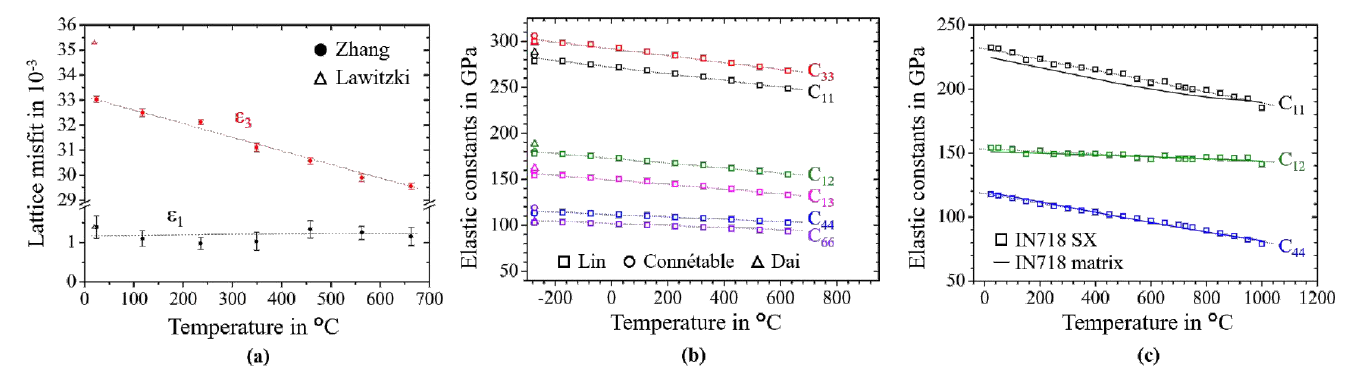
Figure 4. Input parameters used for phase-field simulation as a function of the temperature: ( a ) anisotropic lattice misfit from the literature [6,41]; ( b ) elastic constants of γ″ phase [38–40]; ( c ) measured elastic constants of matrix phase.